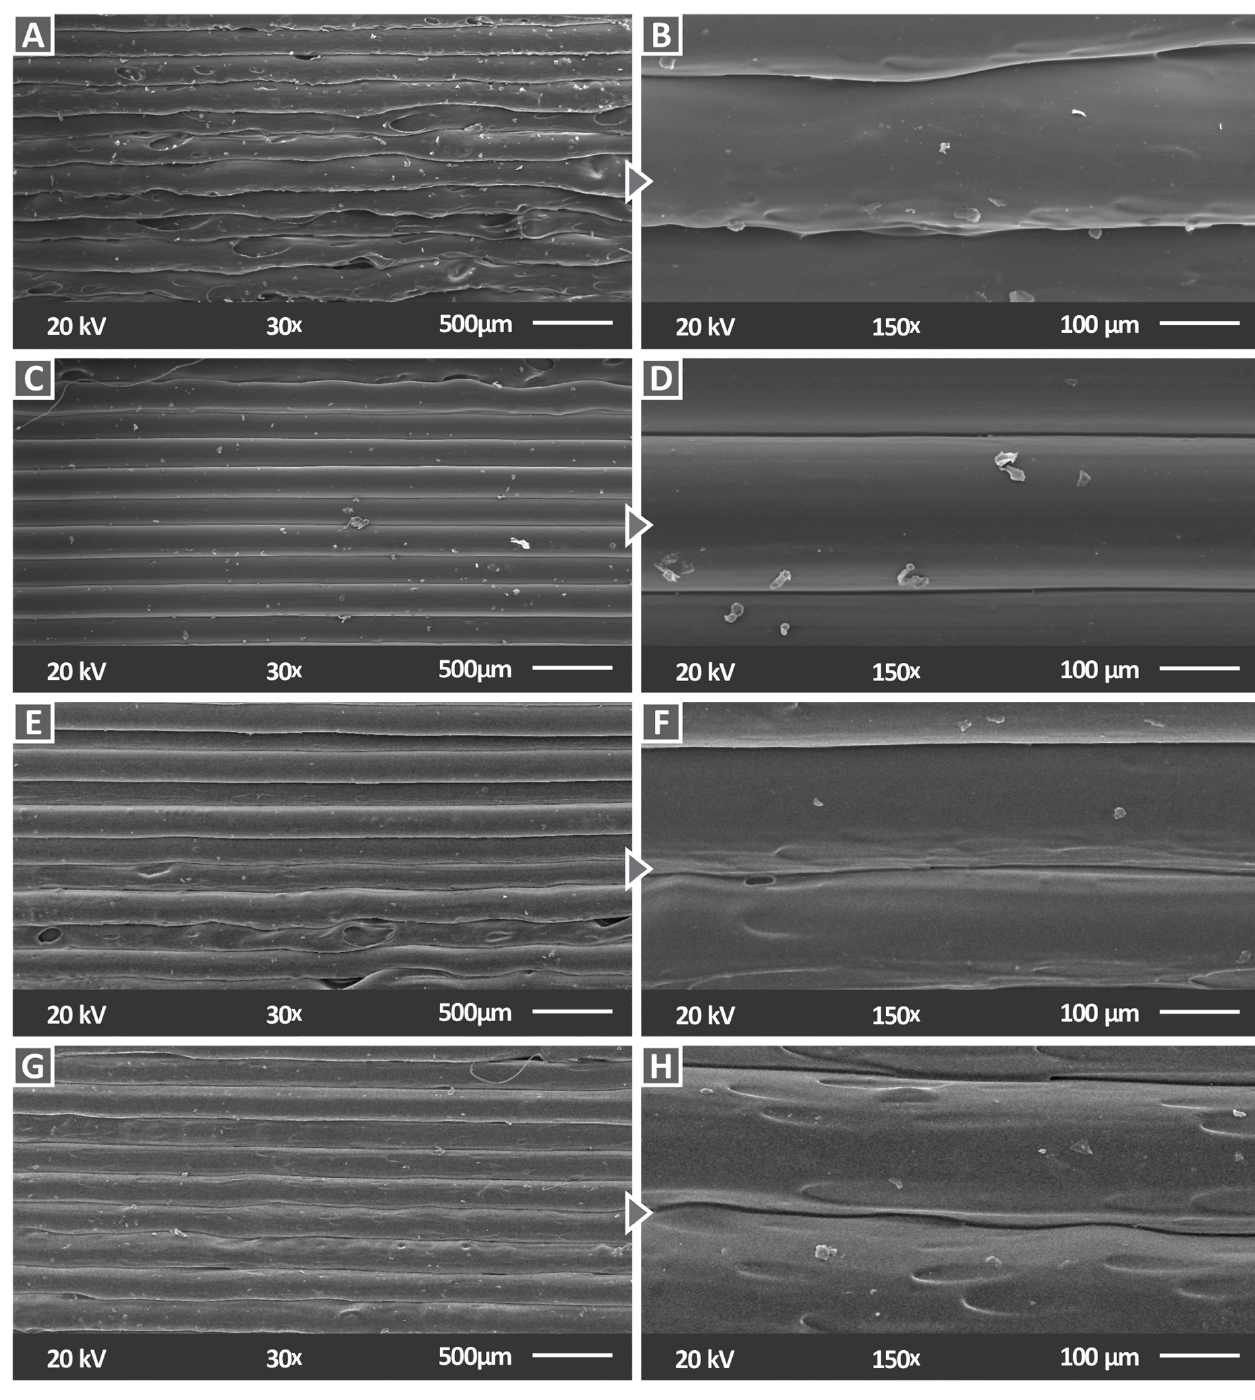
Figure 14. SEM images of the side surface for ( A ) PC/AlN 1 wt.% with 30× magnification, ( B ) PC/AlN 1 wt.% with 150× magnification, ( C ) PC/AlN 2 wt.% with 30× magnification, ( D ) PC/AlN 2 wt.% with 150× magnification ( E ) PC/AlN 3 wt.% with 30× magnification, ( F ) PC/AlN 3 wt.% with 150× magnification, ( G ) PC/AlN 6 wt.% with 30× magnification, and ( H ) PC/AlN 6 wt.% with 150× magnification.